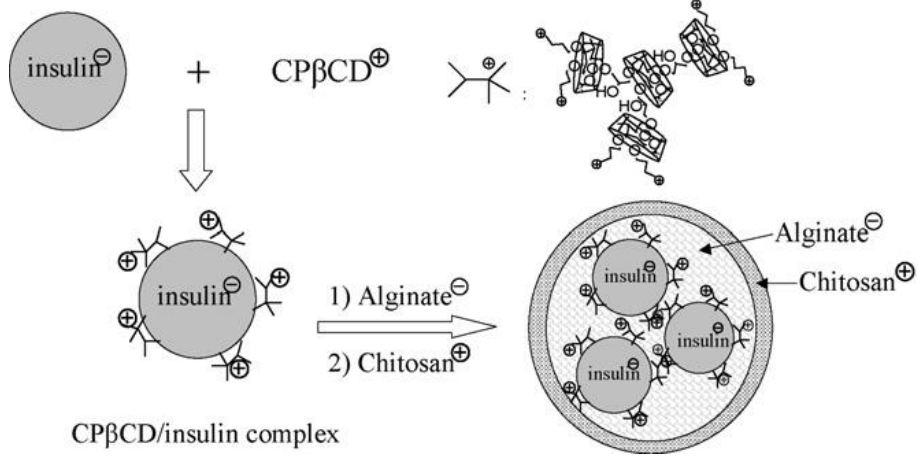
Figure 6. This schematic shows how alginate/chitosan nanoparticles interact with insulin and its protection from oxidation by CPβCDs [84].